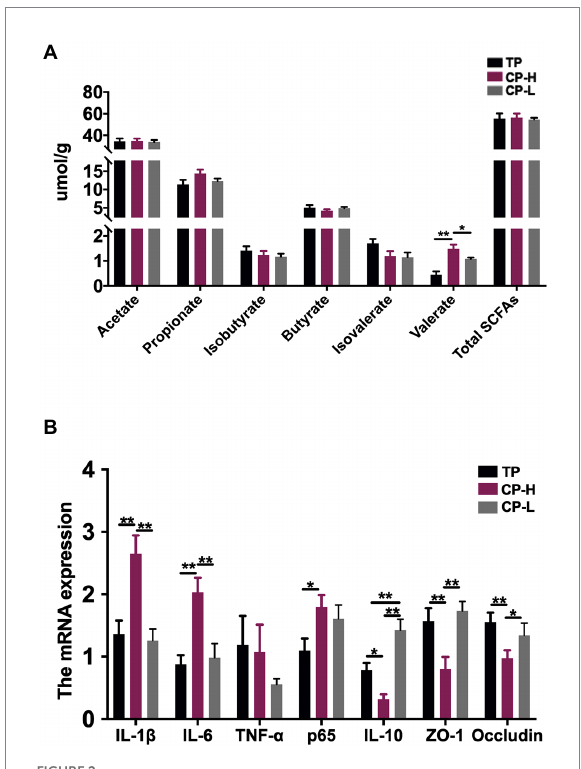
FIGURE 2 Effects of high-altitude hypoxic environment on intestinal inflammation and concentrations of SCFAs in the colonic chyme of pigs. TP: positive control group, CP-H: treatment group, CP-L: negative control group. (A) The concentrations of Acetate acid, Propionic acid, Isobutyric acid, Butyric acid, Isovaleric acid, Valeric acid and total SCFAs in the colonic chyme of pigs. (B) The mRNA expression levels of IL-1 β , IL-6 , TNF- α , p65 , IL-1 0, ZO-1 and Occludin in colonic mucosa of pigs. Data are expressed as mean ± SEM ( n = 6). * indicating a statistically significant difference ( p < 0.05), ** indicating a highly significant difference ( p <